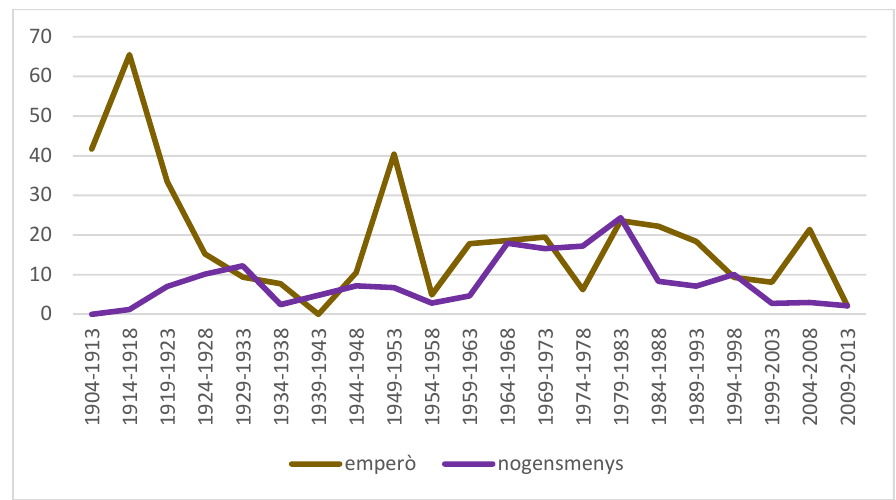
Figure 8. Compared relative frequency of emperò vs. nogensmenys (normalized per 1 million words).